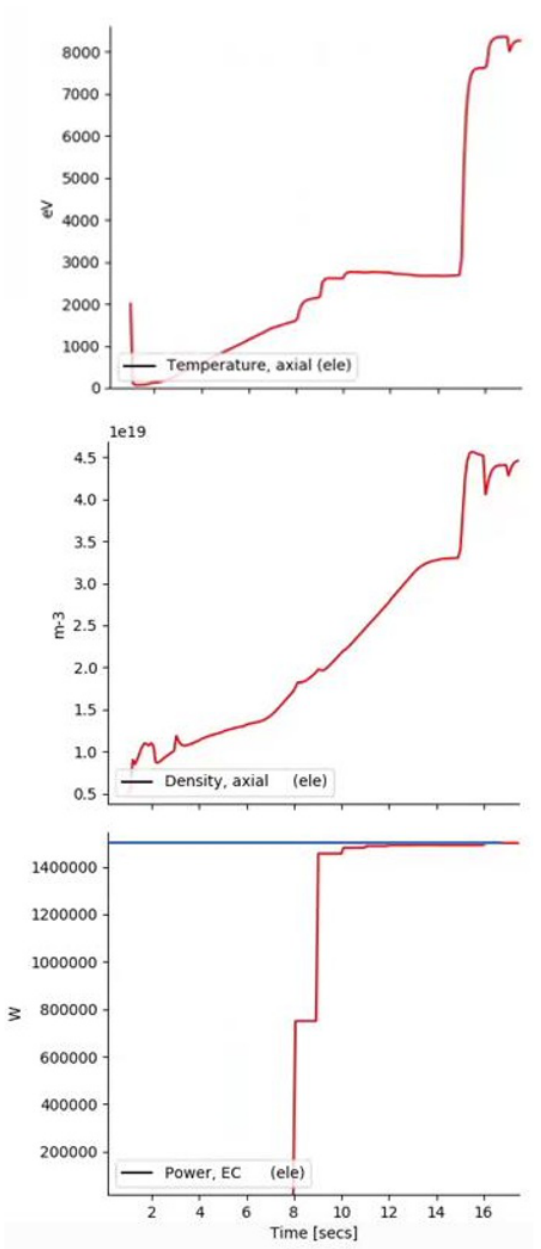
Fig. 3. Time evolution of the axial electron temperature (top), of the axial density (mid) and of the absorbed EC power (bottom) for case 6 simulation in Table